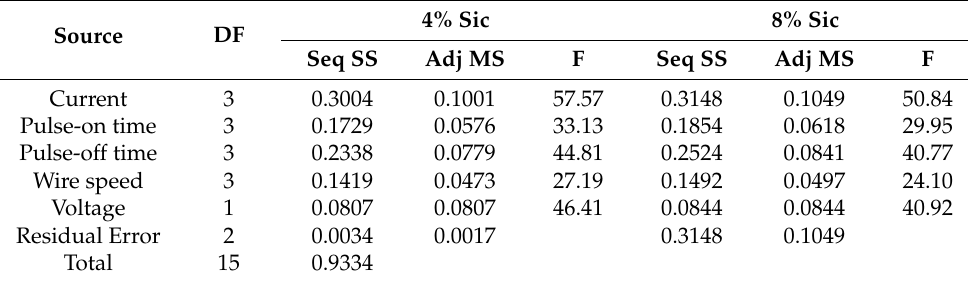
Table 4. Analysis of variance for